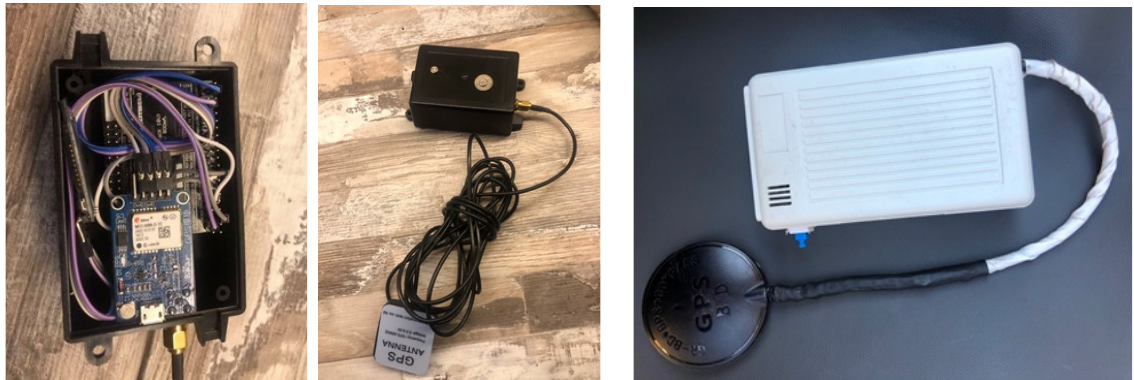
Figure 1. External wireless microelectronic device of the outdoor blind navigation application.